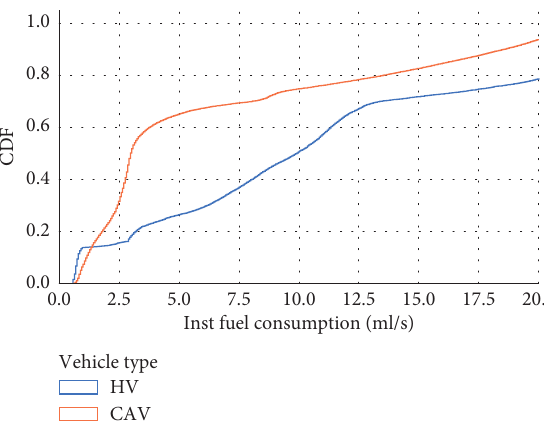
Figure 10: Instantaneous fuel consumption curve for homogeneous